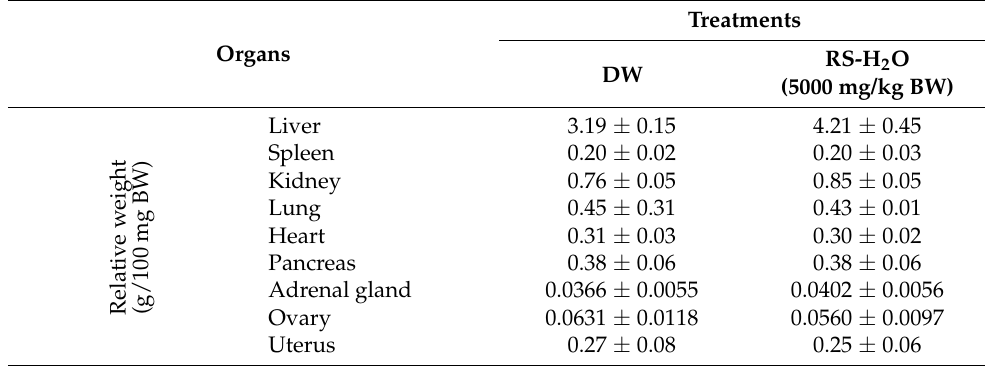
Table 4. Effects of high single dose RS on relative vital organ